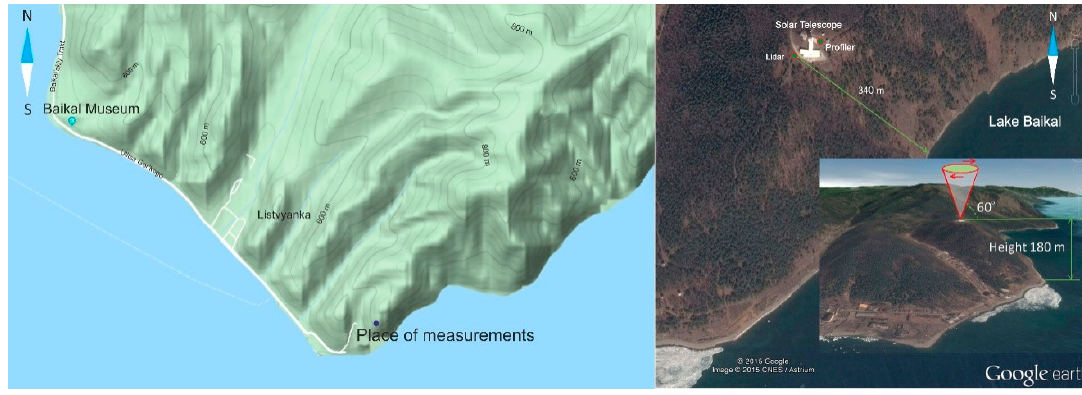
Figure 1. Map of the site of measurements.